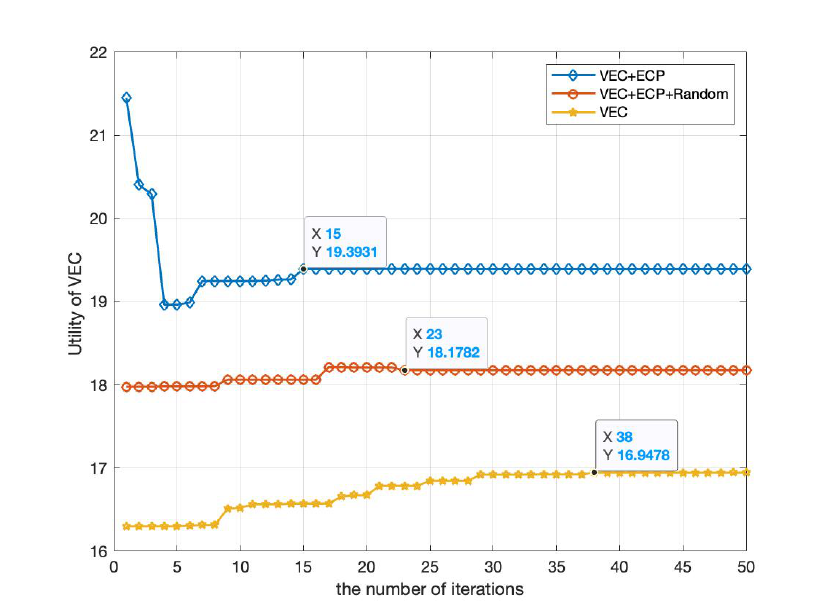
Figure 7. GSA algorithm performance.